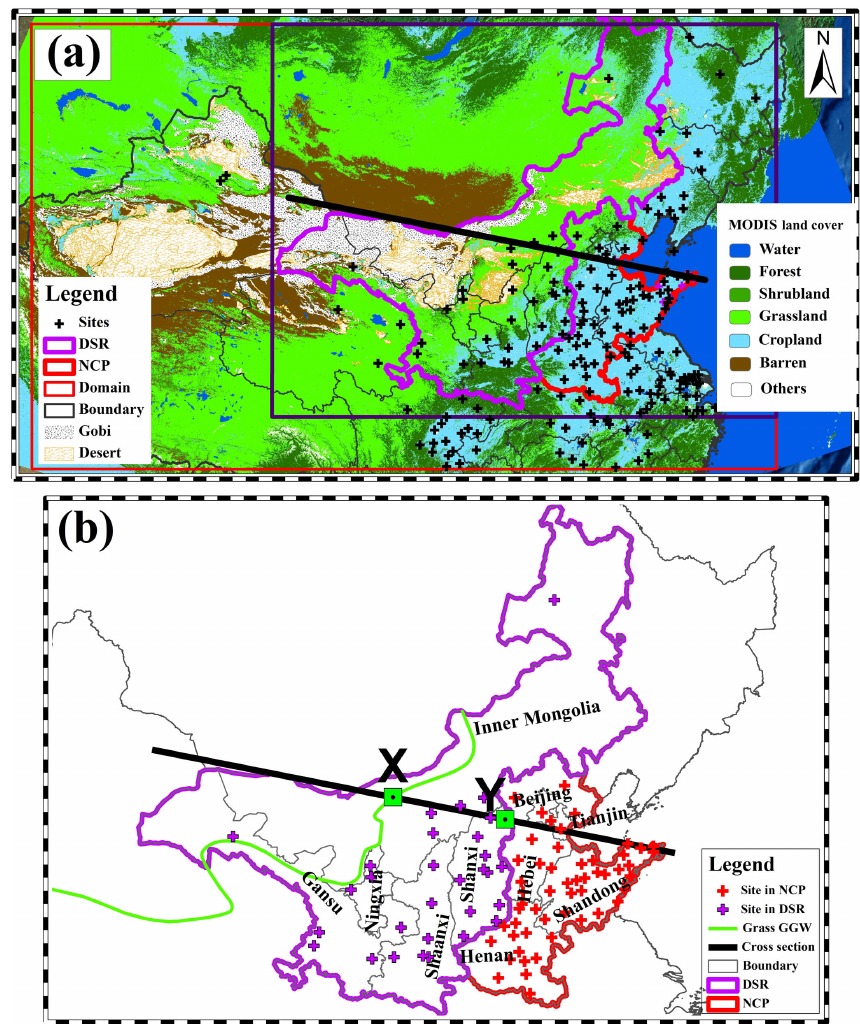
Figure 1. (a) WRF-DUST simulation domain with surface land properties and major natural dust sources in China. (b) The details of ROIs for the dust source region and surrounding areas (DSR) and the downwind North China Plain (NCP) region. The crosses represent centers with ambient monitoring sites. The dark solid line is for the cross section focused on in this study. X and Y are the crossing points of the cross section with the grass Green Great Wall and the boundary of the DSR and the NCP, respectively. The land cover properties are derived from the MCD12Q1 product in the year 2013. The distributions of the Gobi and other deserts are adapted from a 1 : 200000 desert distribution dataset provided by the Environmental and Ecological Science Data Center for West China, National Natural Science Foundation of China (http://westdc.westgis.ac.cn). The DSR contains five provinces in the northwest of the NCP, including Ningxia, Gansu, Shanxi, Inner Mongolia, and Shanxi. The NCP includes the five provinces of Beijing, Tianjin, Hebei, Henan, and